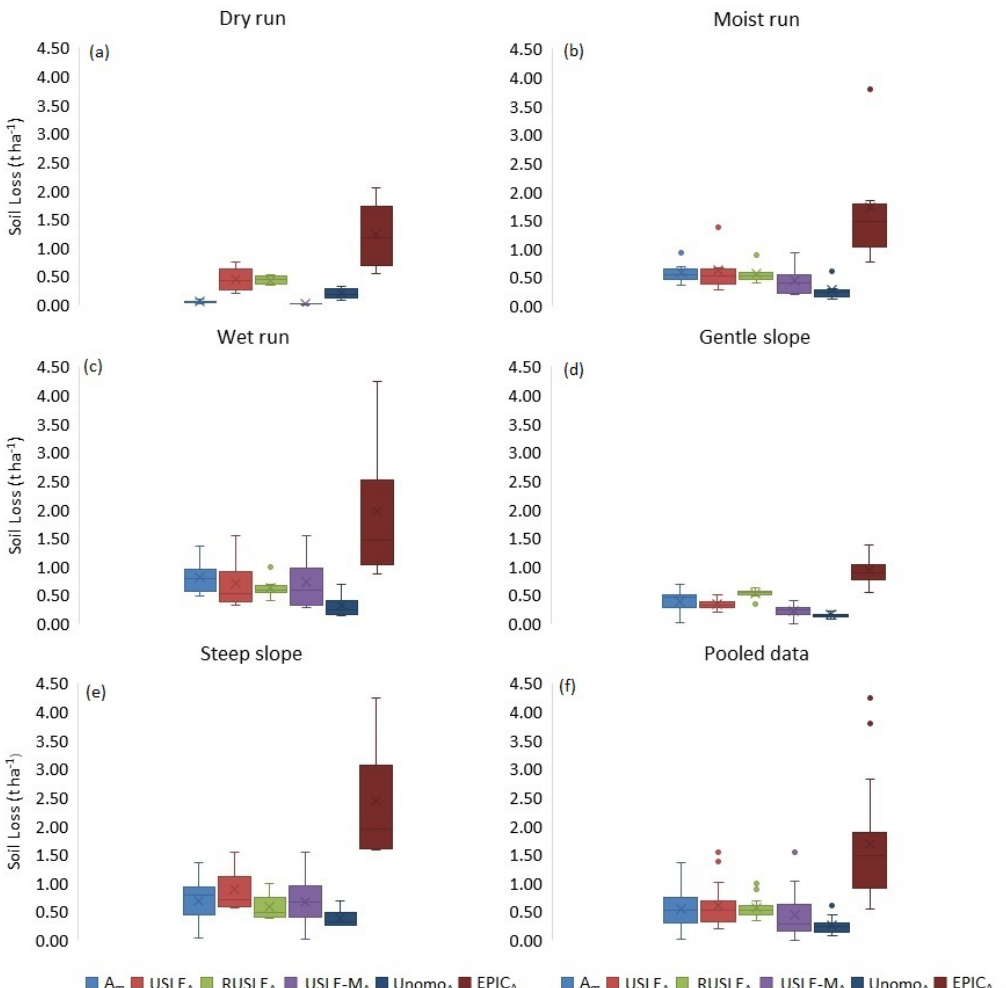
Figure 3. Comparison of measured soil loss (A m ) (t ha − 1 ) and the estimation results by the USLE, RUSLE, USLE-M (t ha − 1 ), USLE (Unomo A ) and EPIC nomograph (EPIC A ) equations according to ( a ) dry runs, ( b ) moist runs, ( c ) wet runs, ( d ) gentle slope, ( e ) steep slope and ( f ) pooled data.